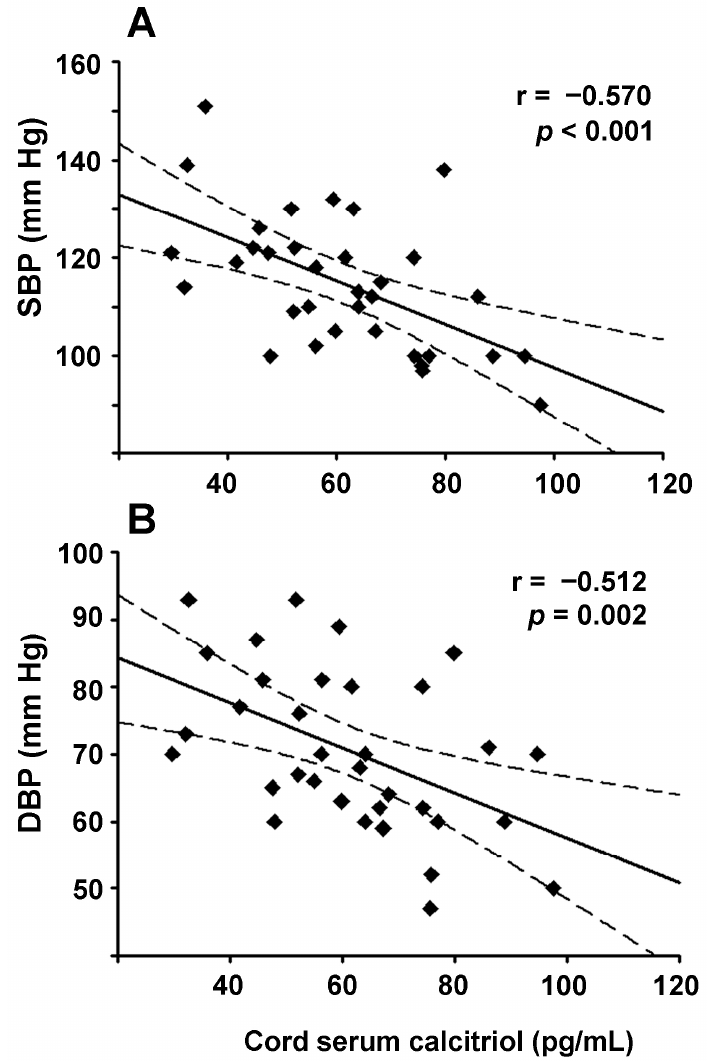
Figure 3. Cord serum calcitriol levels inversely correlated with maternal blood pressure in UTI. Simple linear regression plots show the associations between cord serum calcitriol and maternal systolic and diastolic blood pressure (SBP, DBP; ( A , B ), respectively) in samples from the cohort of urinary tract infection. Dashed lines indicate 95% confidence intervals. Other significant associations found among studied parameters include the positive correlation between calcidiol and calcitriol in the UTI and NP groups (Figure 4A,B, Table 2), which was to be expected since calcidiol is the precursor of calcitriol. When analyzing by neonate sex, this relationship was observed only in the UTI-male subgroup, where cal- citriol and calcidiol strongly correlated with high statistical significance (r = 0.703, p < 0.001). Notably, cord calcitriol negatively correlated with maternal bacteriuria but only in the UTI-female subgroup (r = − 0.636, p = 0.01), while cathelicidin placental gene expression was positively associated with gestational age at delivery in both UTI-male and UTI-fe- male subgroups as well as with some neonate anthropometric parameters (Table 2). On